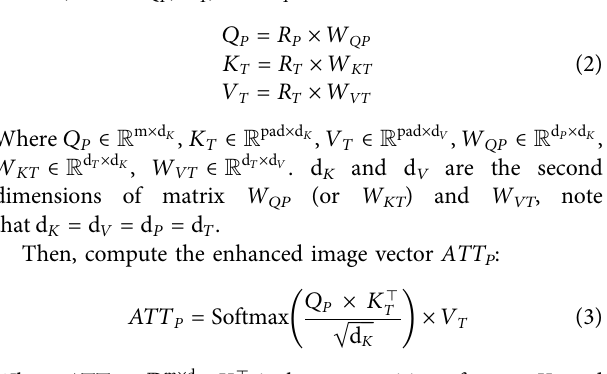
FIGURE 3 | Structure of the ResNet-18 unit. Instruction : Dotted lines represent residual